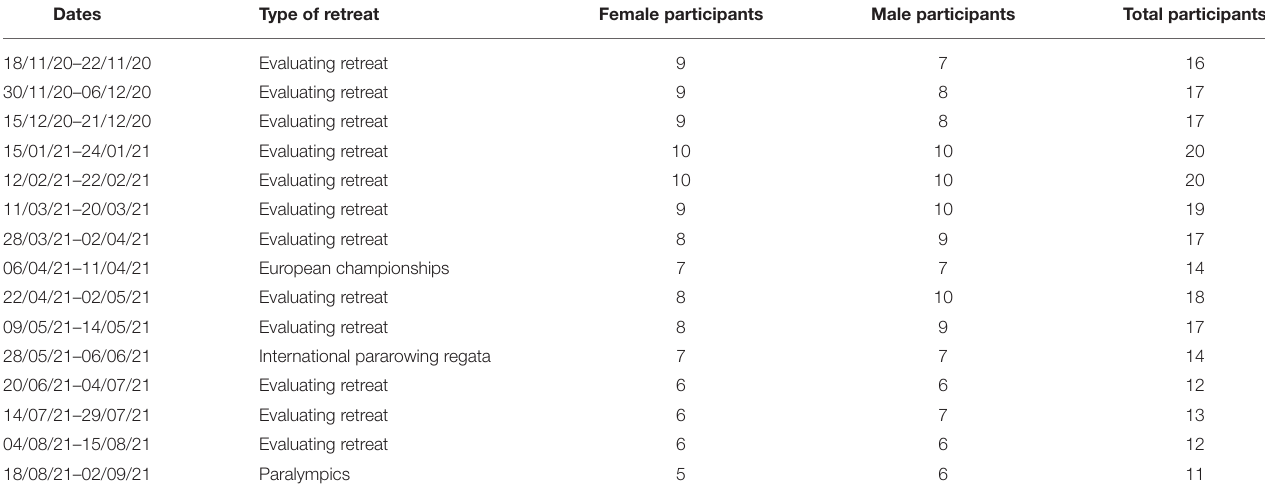
TABLE 2 | Date of retreats and number of participants per